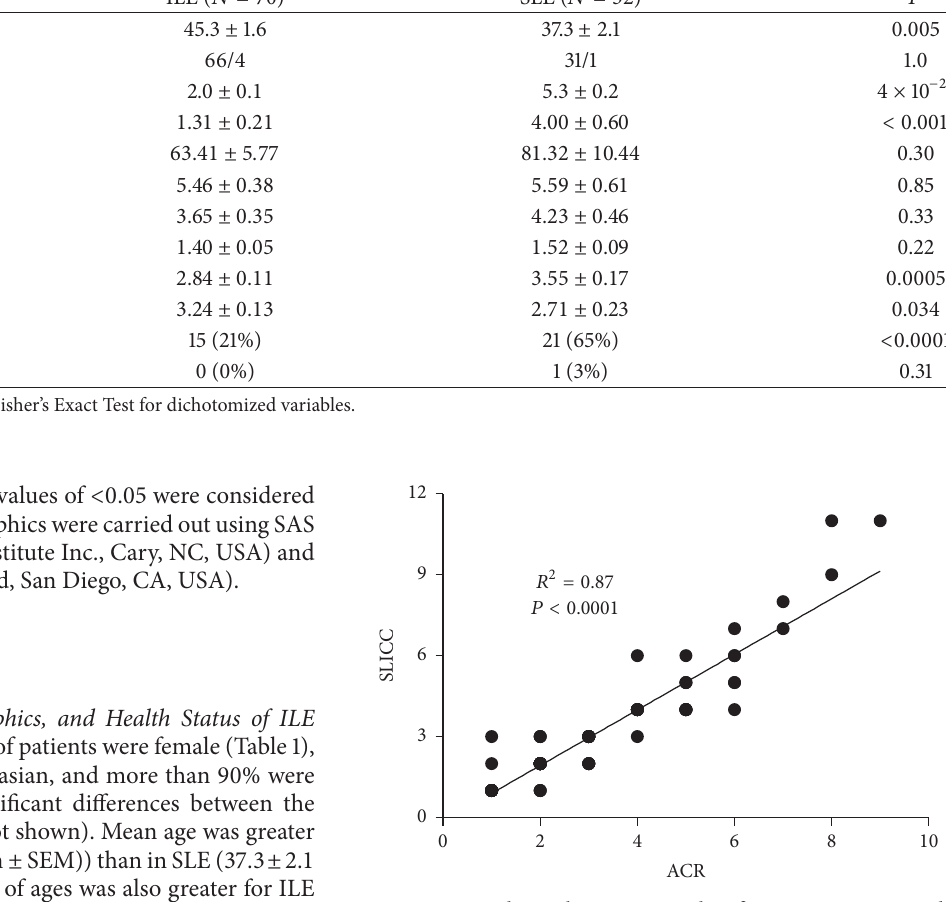
Figure 1: Correlation between two classification SLE criteria, the 1997 ACR and 2012 SLICC sets, in 102 patients with either ILE or SLE. Values on each axis correspond to numbers of criteria in each of the sets. Significance determined using Pearson’s 𝑅